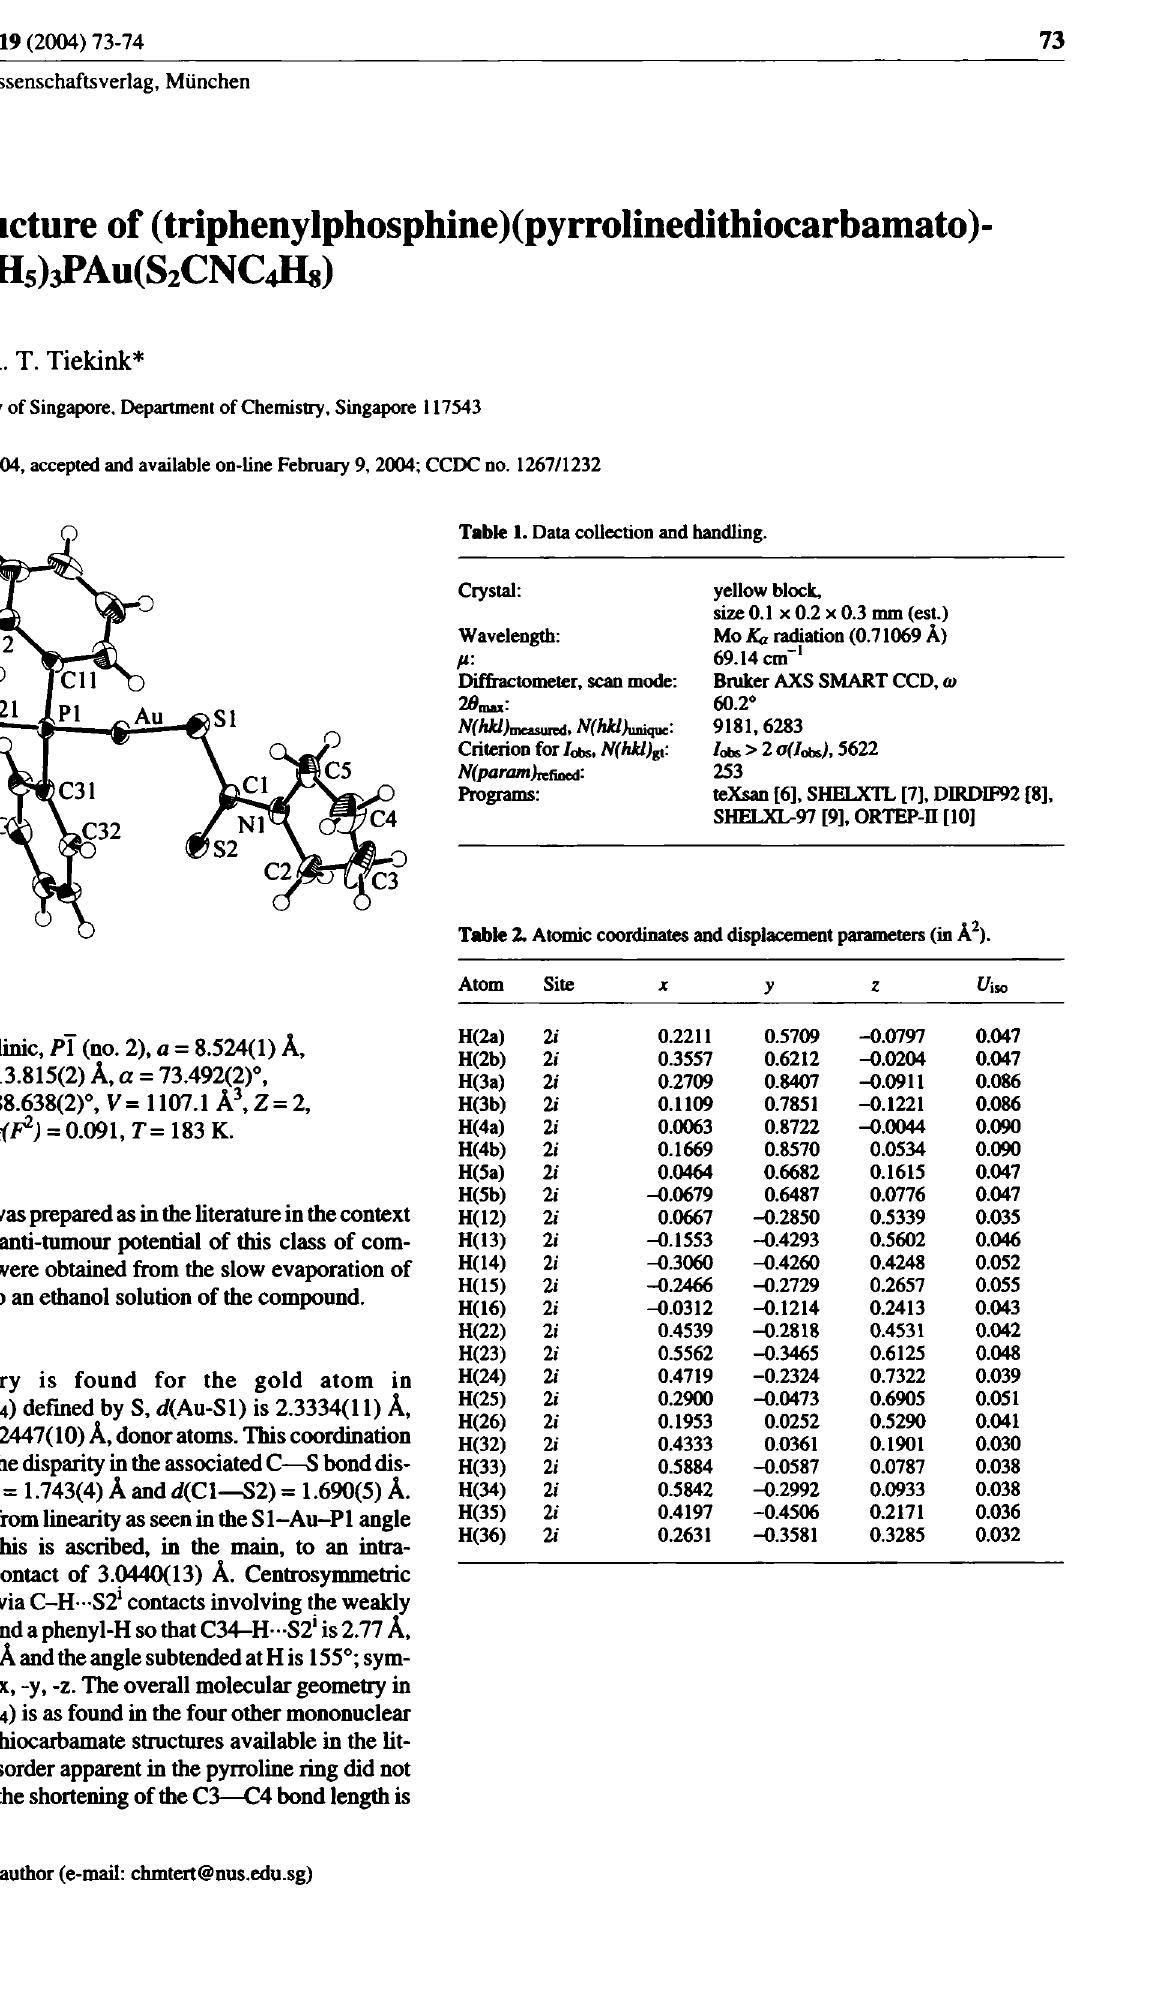
Table 2. Atomic coordinates and displacement parameters (in À 2